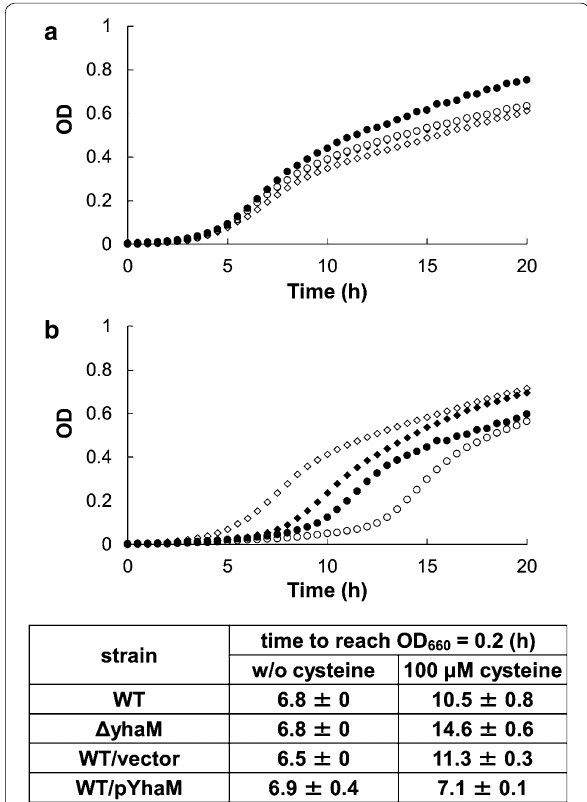
Fig. 2 Effects of yhaM expression on growth in the presence of cysteine at toxic concentrations. a Growth curves for wild-type E. coli MG1655 ( closed diamond ), MG1655Δ yhaM ( open diamond ), MG1655/ vector (pSTV29) ( closed circle ), and MG1655/pYhaM (pSTV-yhaM7) ( open circle ) in the presence of 0 μM ( top ) or 100 μM ( bottom ) of cysteine. Representative growth curves are shown. b Culture time ( h ) required for wild-type E. coli MG1655, MG1655Δ yhaM , MG1655/vector (pSTV29), and MG1655/pYhaM (pSTV-yhaM7) to obtain OD 660 the absence (w/o cysteine) or presence of cysteine (100 μM). Values represent the averages based on two independent